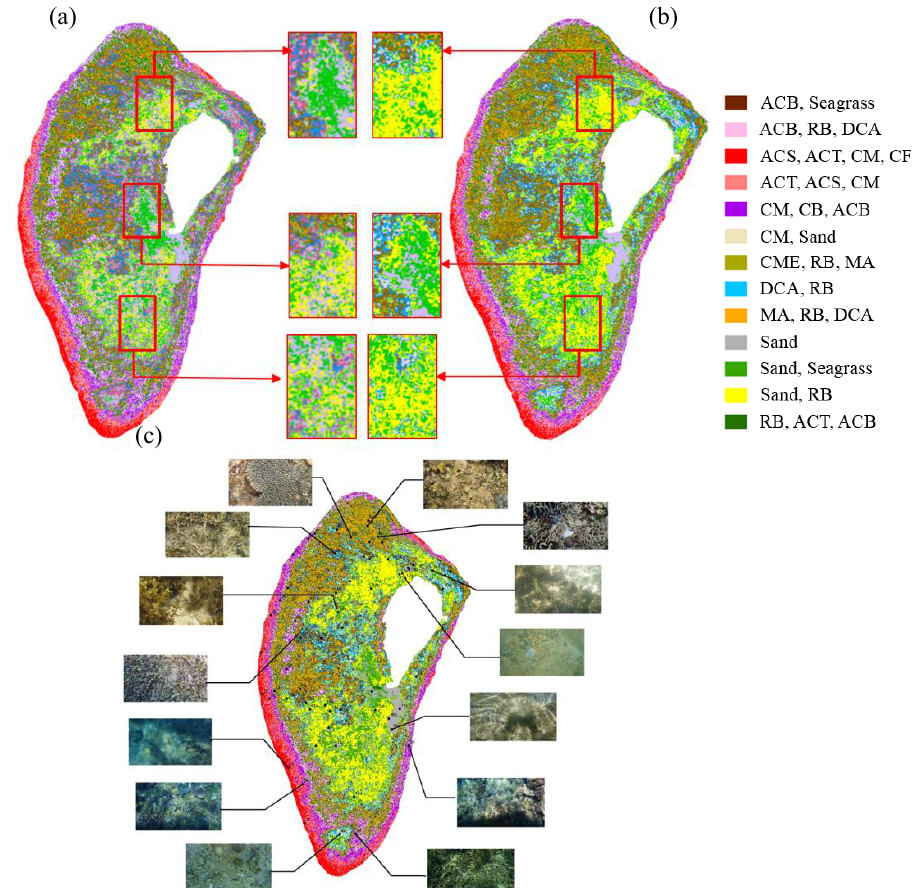
Figure 4. Differences in reclassification results with the IsoData and K-Means methods on SPOT-4 images. (a) The results of reclassification using the IsoData method, (b) Results of reclassification using the K-Means method, and (c) field